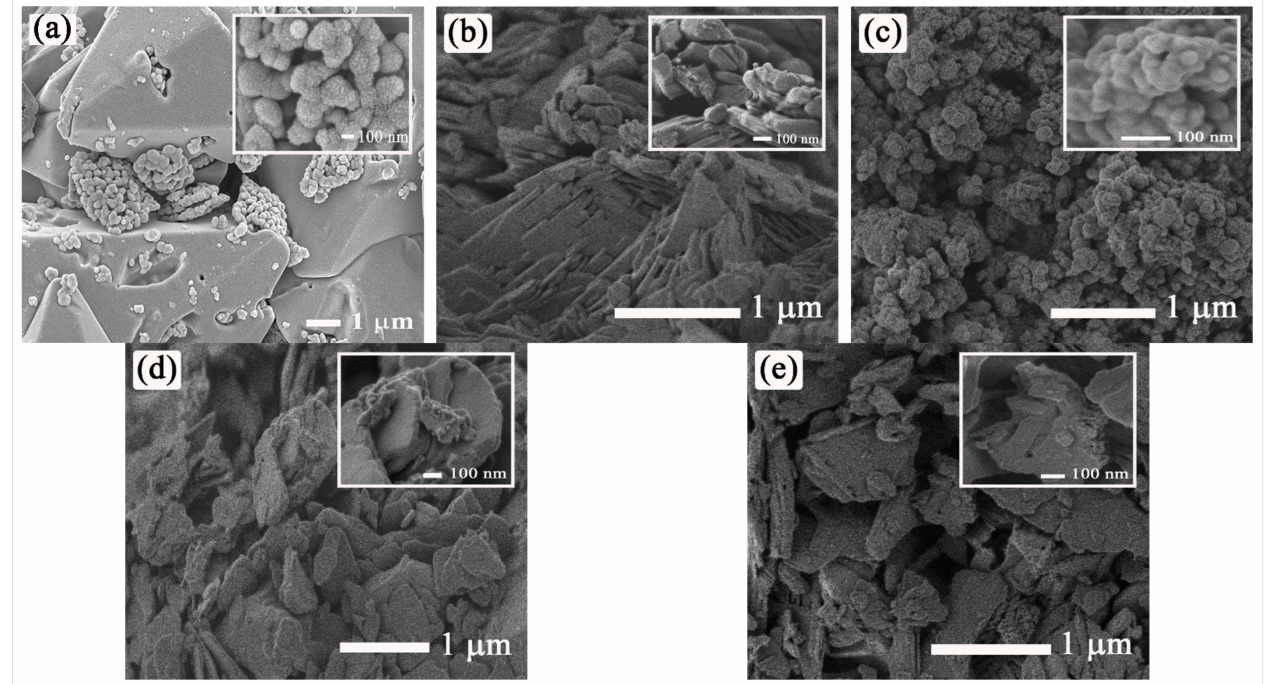
Figure 4. SEM images of ( a ) ZnO, ( b ) La-ZnO, ( c ) Ce-ZnO, ( d ) Pr-ZnO and ( e ) Nd-ZnO calcined to 700 ◦